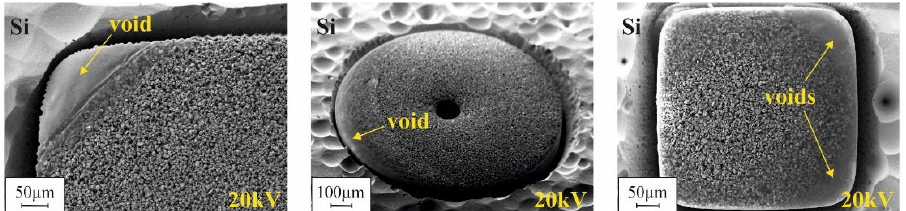
Figure 18. SEM micrographs of the bottom side of various micromagnets fabricated utilizing manual filling with compaction after removal of the surrounding silicon in XeF2 gas phase as illustrated in Figure 15. All micrographs were obtained with an acceleration voltage of 20 kV.